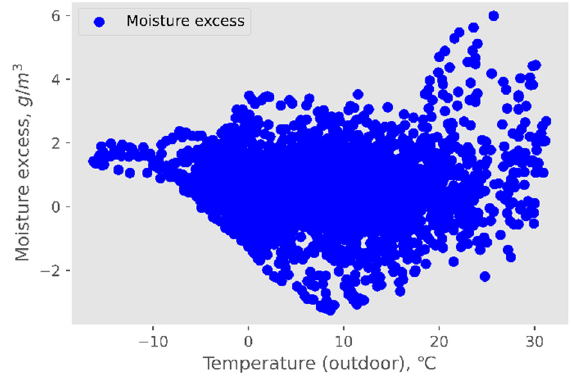
Figure 10. Moisture excess in Turaida church on the lamp.